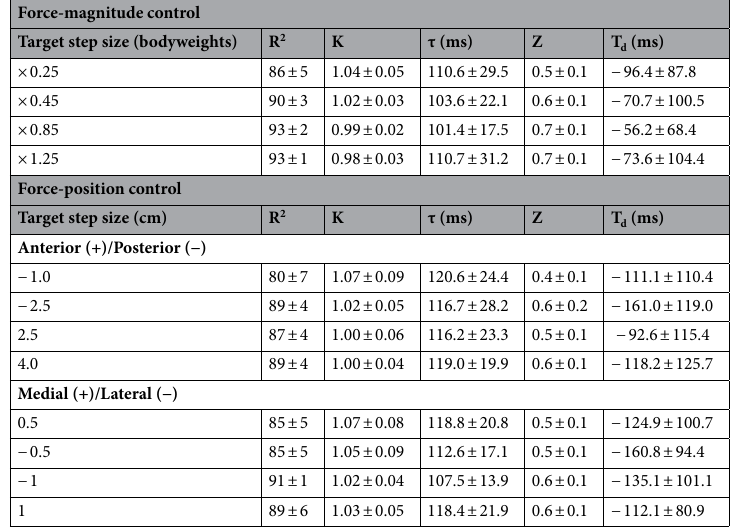
Table 2. Average best fitting system modelling parameters describing leg force control as a second-order system. The R 2 represents the fit, K is the gain used to determine error (1 being no error in the system), τ is the time constant characterizing the rate of change of how quick the system changes state, Z is the damping constant where a value of < 1 indicates an underdamped system and T d is the time delay (or lead time) which is the time delay of when the system first begins to respond (a negative value indicates the system is predicting and responding before the step target steps